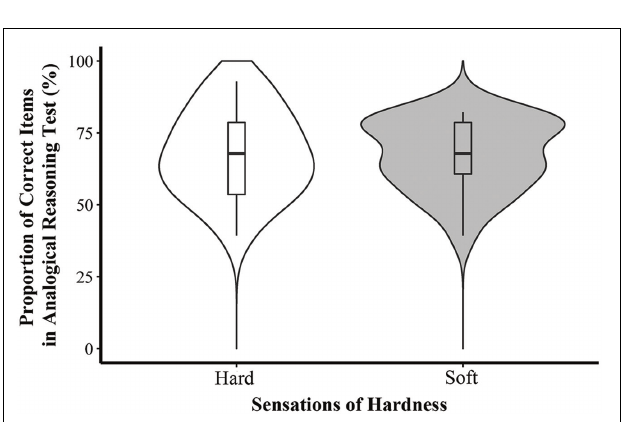
FIGURE 3 | Proportion of correct answers in analogical reasoning task in Experiment